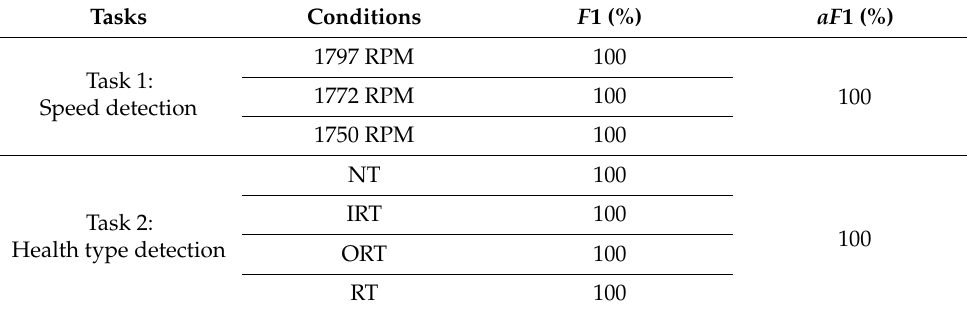
Table 7. Diagnostic performance of the CWRU